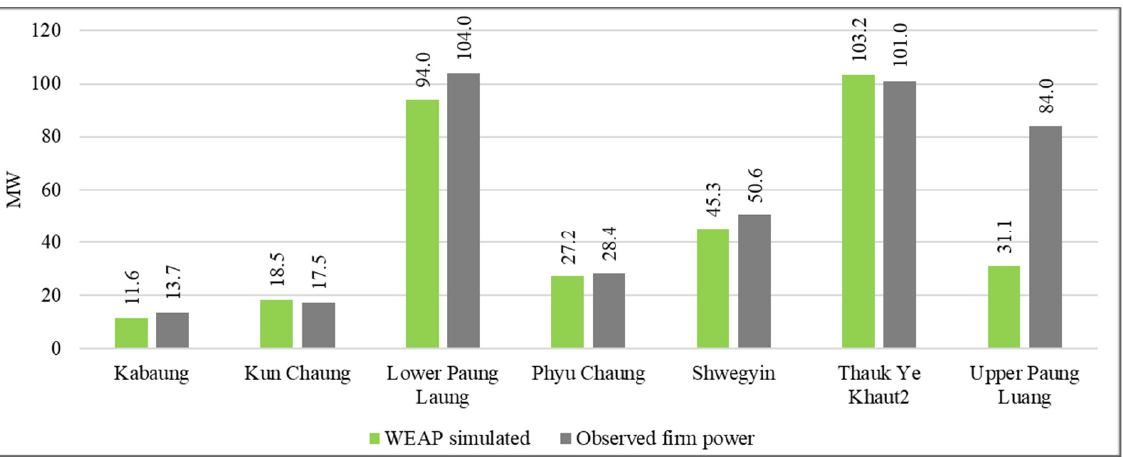
Figure 9. WEAP ‐ simulated and observed firm power in the selected hydro ‐ powers of the SRB. Figure 9. WEAP-simulated and observed firm power in the selected hydro-powers of the